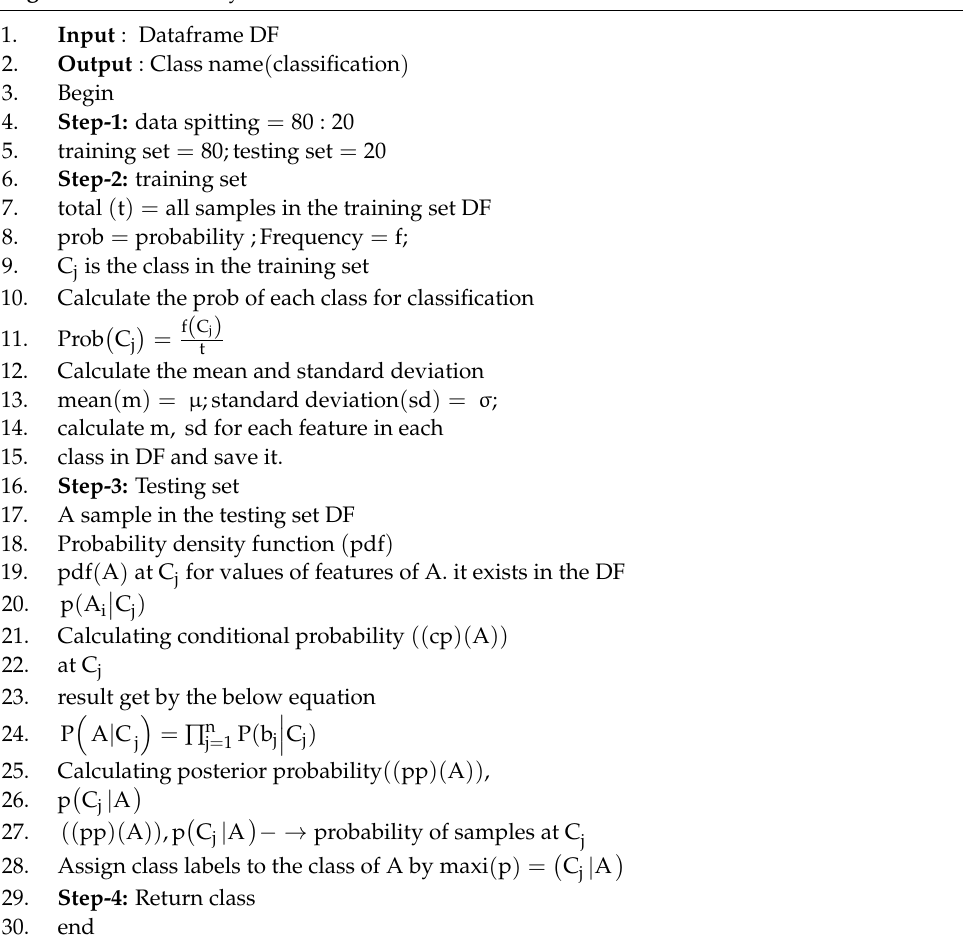
Algorithm 2: Naïve